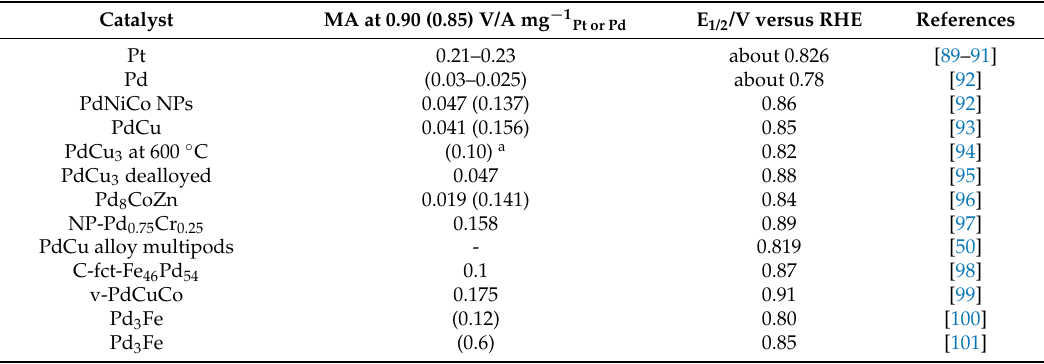
Table 3. MA at 0.9 (0.85) V versus RHE and E 1/2 for ORR of various Pd-based catalysts in an O 2 - saturated HClO 4 aqueous solution.